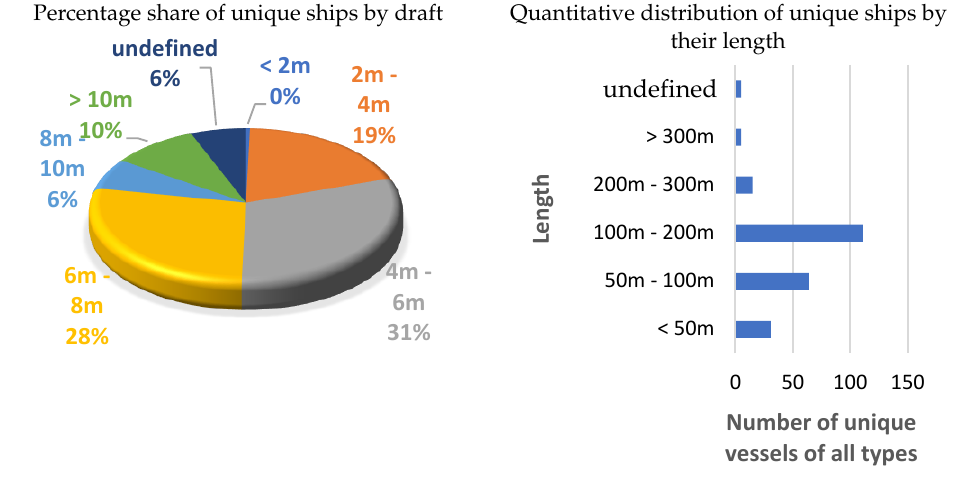
Table 12. Qualitative characteristics of all types of ships. Percentage share of unique ships by draft